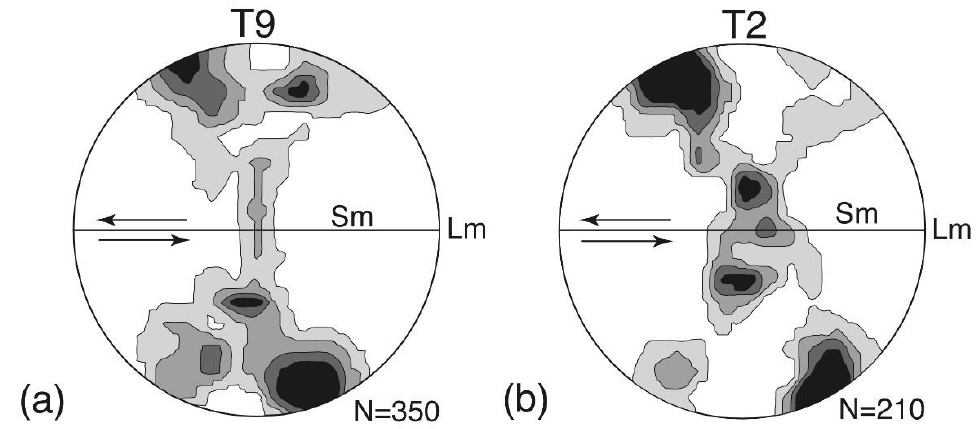
Figure 5. Typical examples of each of ( a ) type I (T9) and ( b ) type II (T2) crossed girdle quartz c -axis fabrics in quartz schist samples from the study area. Upper-hemisphere and equal-area projections. Contours are 1%, 2%, 3%, and 4% per 1% area, and shaded above 1% per 1% area. Sm and Lm indicate foliation defined by the shape fabric of phengite, and lineation defined by that of amphibole and/or elongate quartz. A couple of arrows indicates the sense of shear inferred from the asymmetry of quartz c -axis fabric patterns showing a top to the west sense for both samples. N is the number of measurements. Localities of samples T9 and T2 are shown in Figure 2. These quartz c -axis fabrics, which are reproduced after [61], are also reproduced in [40,46].